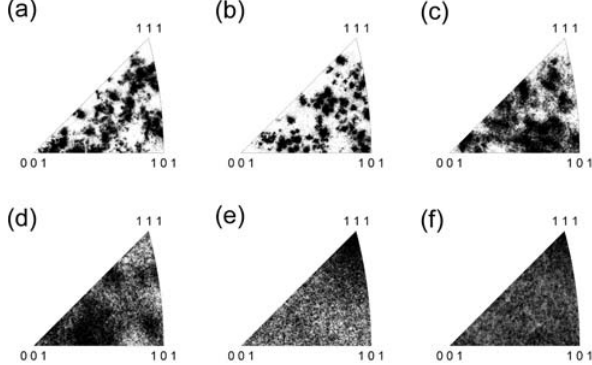
Figure 6: IPFs of the Mo ss phase in the MoSiBTiC alloy crept at 1,500°C and 137 MPa with creep stains of ( a ) 0%, ( b ) 3%, ( c ) 12%, ( d ) 32%, ( e ) 53%, and ( f ) 72%. The IPFs corresponding to Figure 5 ( a – f ) , respectively.